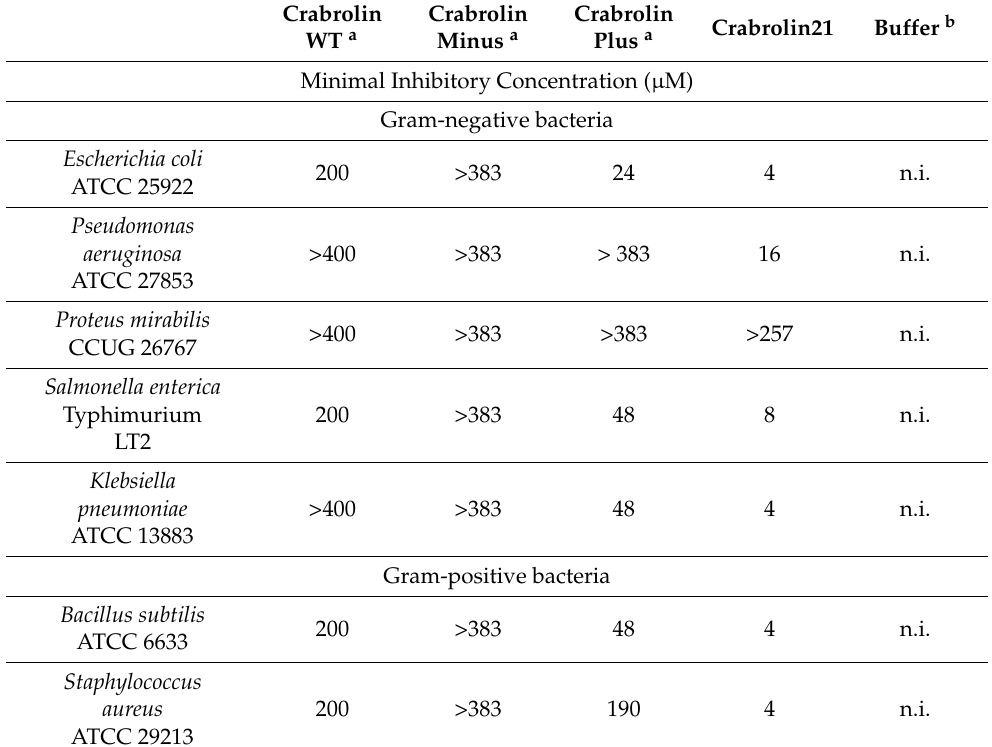
Table 1. Minimal inhibitory concentration (MIC) for crabrolin21 and comparison with previous crabrolins (crabrolin WT, crabrolin Plus, and crabrolin Minus). ( a ) Values are from [14] and ( b ) no inhibition (n.i.) tested until 600 µ M. Crabrolin Crabrolin Crabrolin WT a Minus a Plus a Minimal Inhibitory Concentration ( µ M) Gram-negative bacteria Escherichia coli ATCC 25922